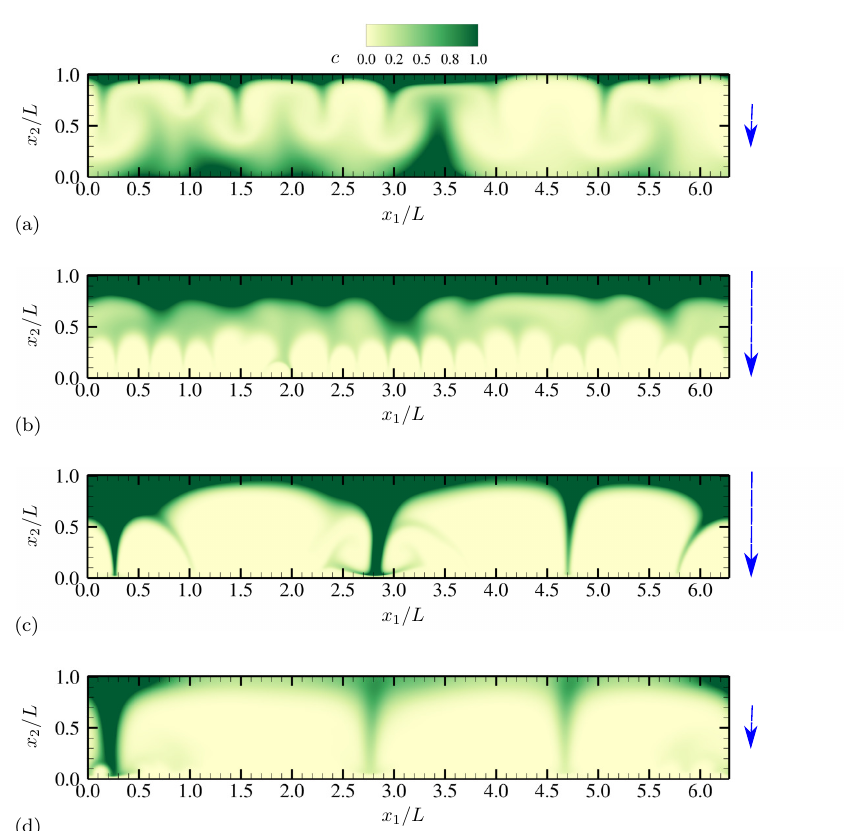
Figure 20. Time series of salt concentration c for half an oscillation period at ( a ) θ = 0.64 π , ( b ) 0.88 π , ( c ) 1.12 π and ( d ) 1.4 π . The vertical arrows denote the direction and relative magnitude (not to scale) of the applied electric field. The diffusivity ratio is D − / D + =